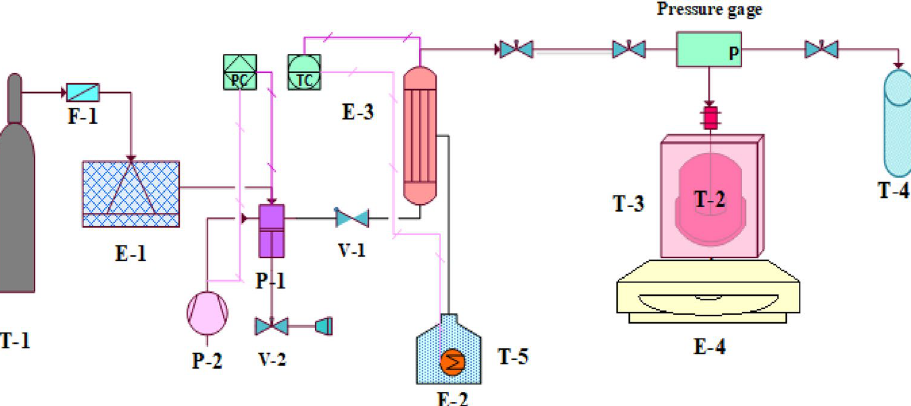
Figure 1. SC-CO 2 producing and reaction apparatus. (E-1) Refrigerator, (E-2) water heater, (E-3) Heat exchanger, (E-4) Heater stirrer, (F-1) Filter, (P-1) High pressure pump, (P-2) Air compressor, (T-1) CO 2 tank, (T-2) Polymerization reactor, (T-3) Paraffin bath, * (T-4) vent collector, (T-5) Water tank, (V-1) One-way pressure breaker valve, (V-2) Vent valve. *This is a glass open-door